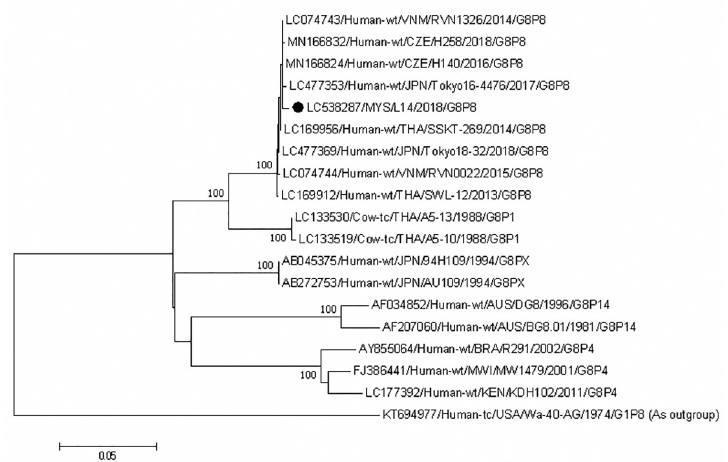
Fig 5. Phylogenetic tree constructed with the nucleotide sequences of the VP7 gene of G8 strains. Human rotavirus Wa-40-AG (G1) was used as an outgroup. The number adjacent to the node represents the bootstrap value and values lower than 70% have not been indicated. Scale bar shows genetic distance expressed as nucleotide substitutions per site. The strains identified in this study are marked with a filled circle. The nucleotide sequences of our strains have been submitted to the databases of the DNA DataBank of Japan, the European Molecular Biology Laboratory, and GenBank. The accession numbers are shown at the beginning of each strain.